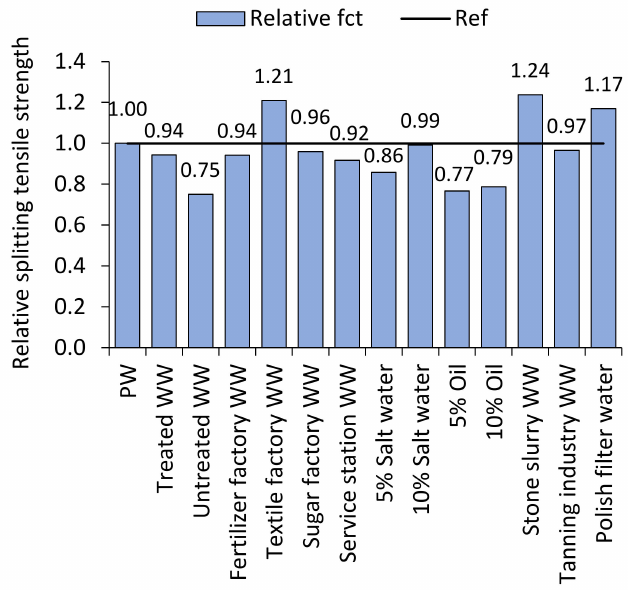
Figure 11. Effect of different types of WW on the splitting tensile strength of concrete relative to that of potable water